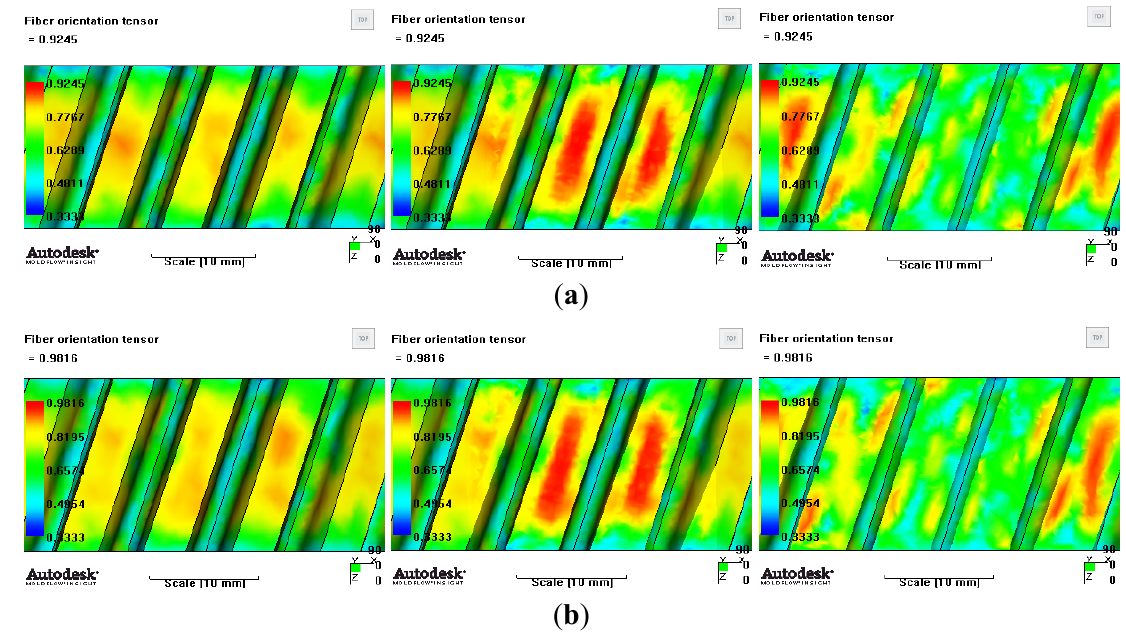
Figure 8. Glass fiber orientation analysis of helical worm wheel: ( a ) Upper, center and low layer from the top of tooth (PA66 + GF25 wt %); ( b ) Upper, center and low layer from the top of tooth (PA66 + GF50 wt %).